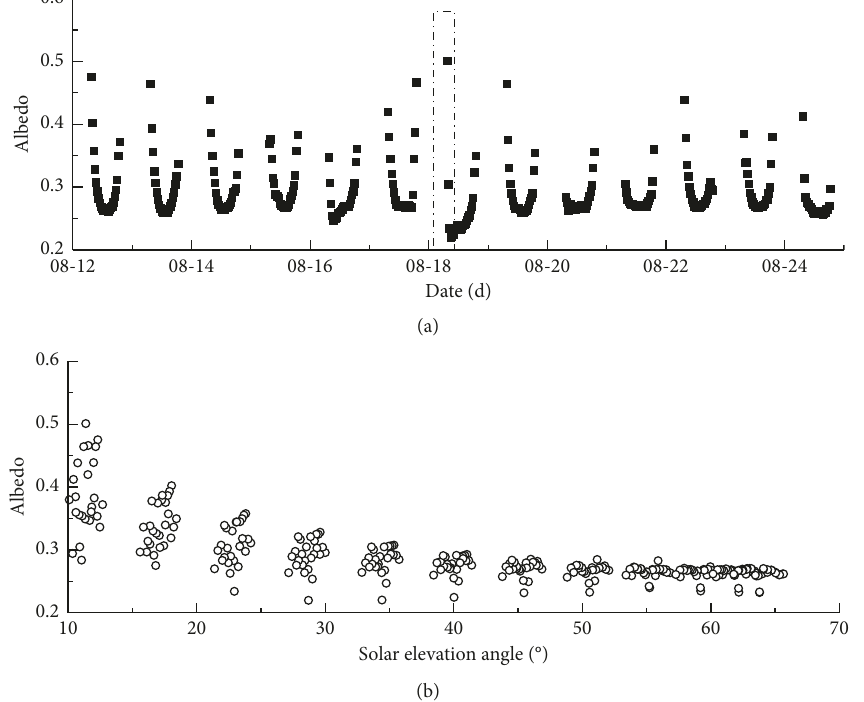
Figure 5: (a) Variations in the surface albedo before and after rainfall (the dashed-dotted rectangle represents the short-term rainfall period); (b) variations in the surface albedo at different solar elevation